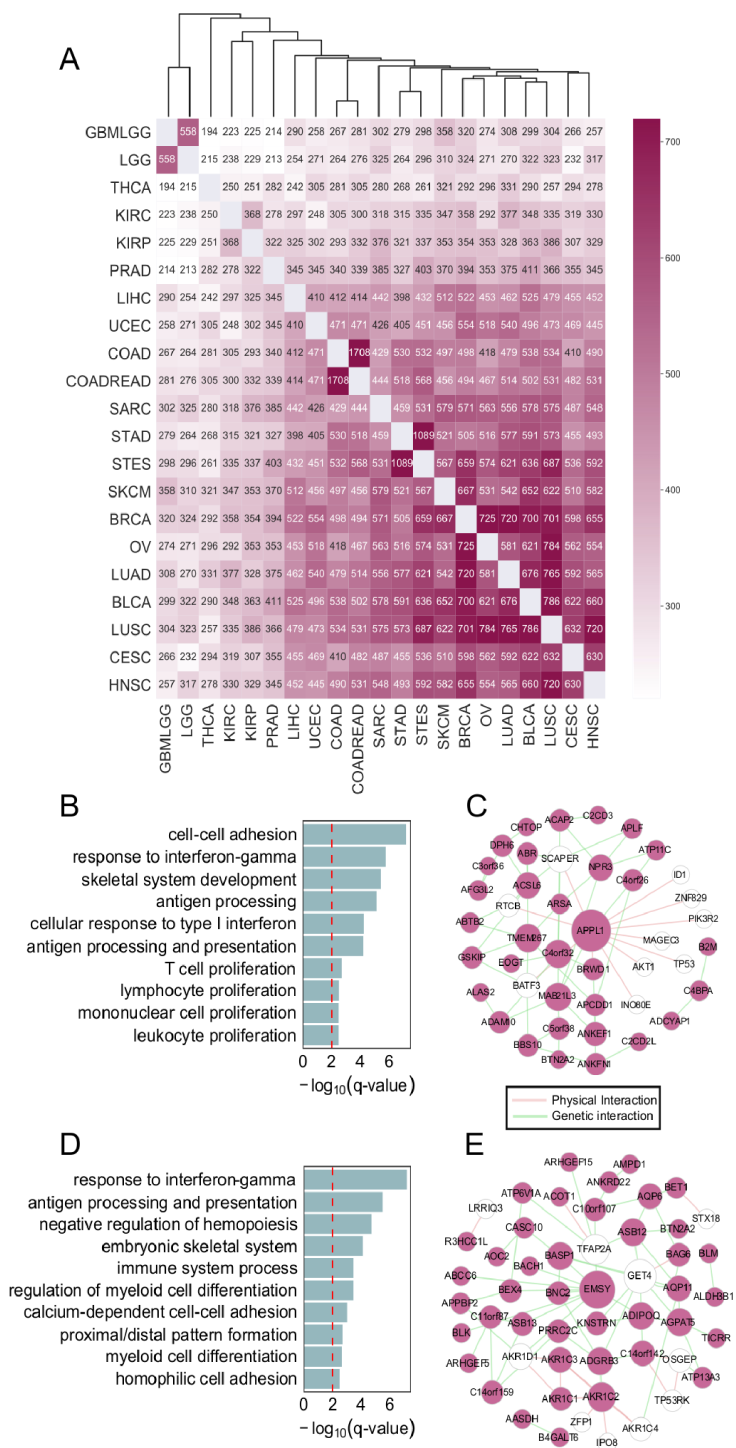
Fig 4. Highly interrelated genes and their biological functions among 21 cancers. (A) Heatmap of the number of highly interrelated genes selected by ADC between each pair of cancers (FDR = 0.05). Hierarchical clustering was performed with the reciprocal value of the number. (B and D) The top ten enriched functional terms of these selected genes between HNSC and CESC (B), BRCA and OV (D) respectively. (C and E) The gene network constructed with GeneMANIA using the selected genes between HNSC and CESC (C), BRCA and OV (E) respectively.